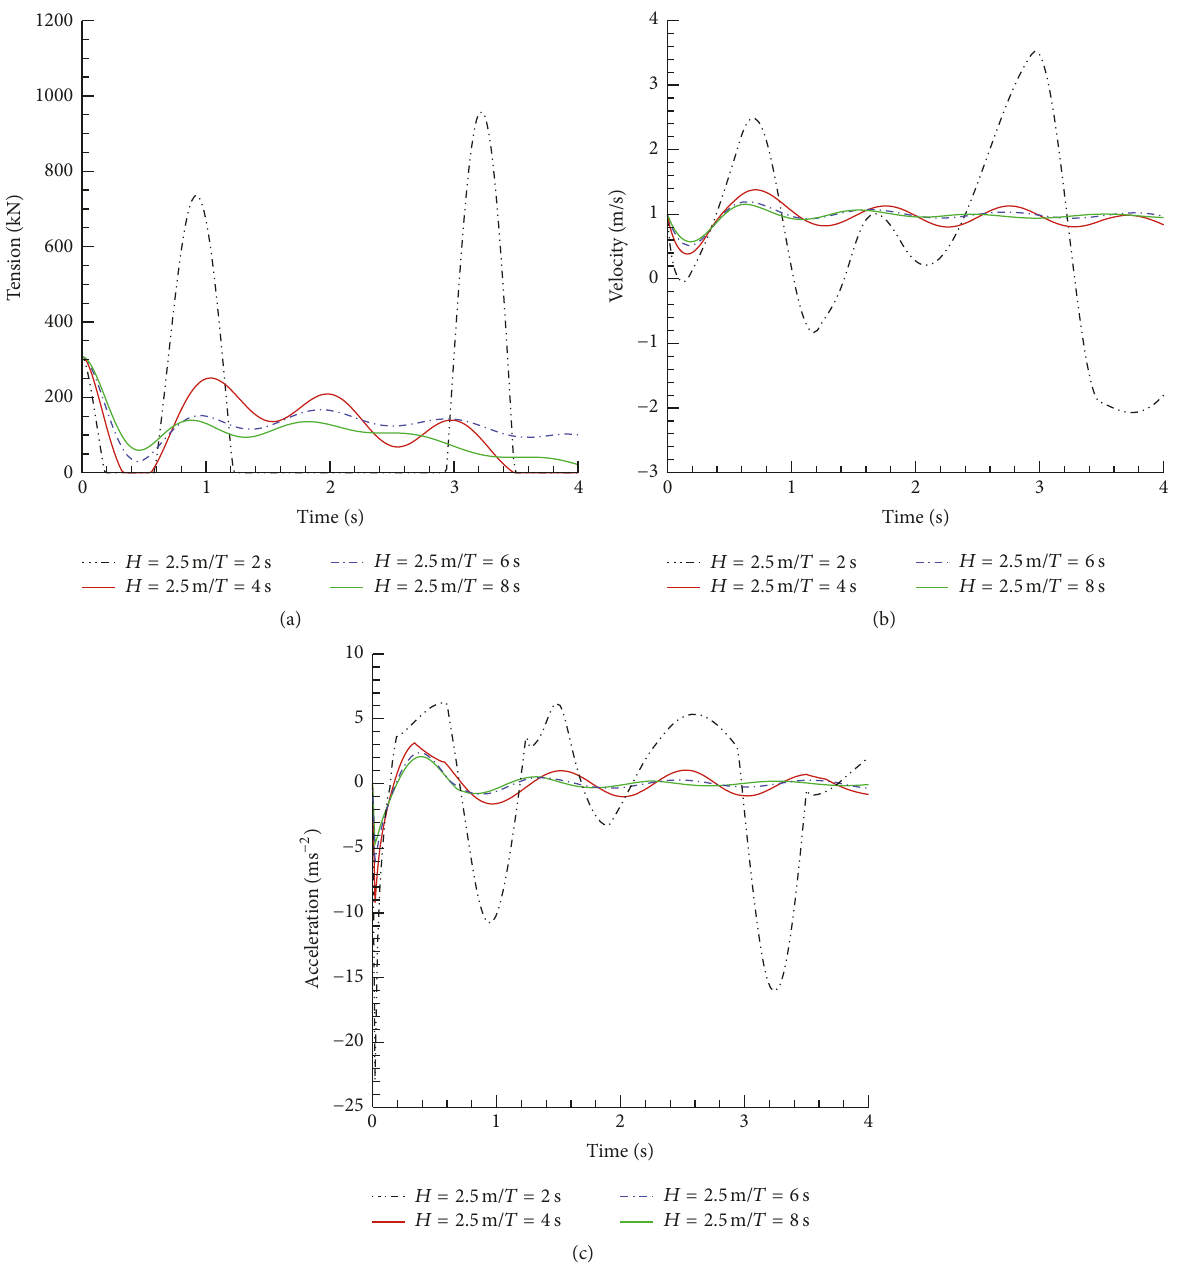
Figure 12: Influence of wave periods: (a) tension acting on the cylinder; (b) velocity of the cylinder; (c) acceleration of the